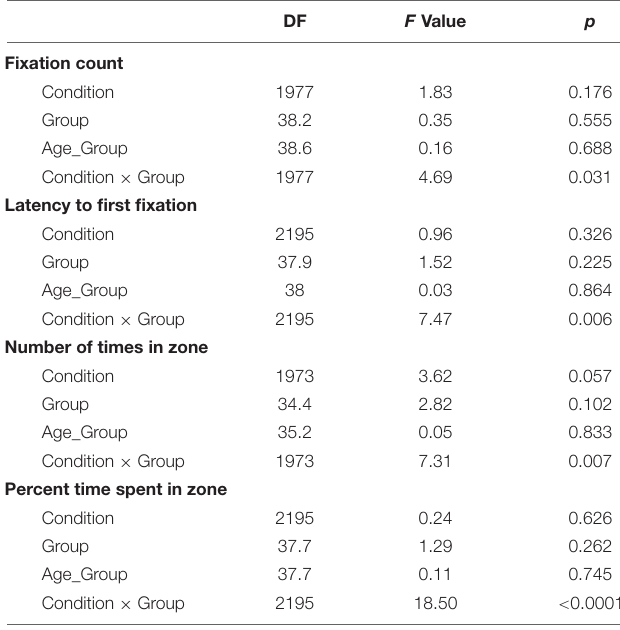
TABLE 1 | Type 3 tests of fixed